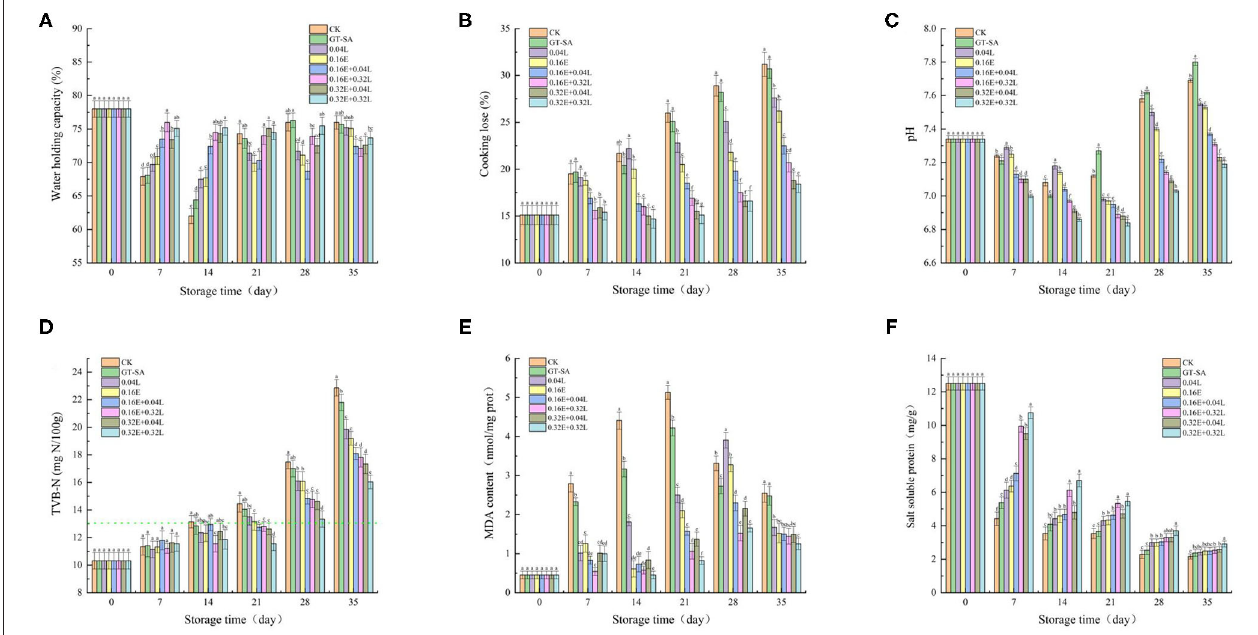
FIGURE 2 | Changes in water holding capacity [WHC, (A) ], cooking lose (B) , pH (C) , total volatile basic nitrogen values [TVB-N, (D) ], malondialdehyde content [MDA, (E) ], and salt soluble protein content (F) of large yellow croaker samples during superchilling storage (CK, uncoated; GT-SA, GT-SA coating without preservatives; 0.04L, GT-SA coating with 0.04 mg · ml − 1 LYS; 0.16E, GT-SA coating with 0.16 mg · ml − 1 EGCG; 0.16E + 0.04L, GT-SA coating with 0.16 mg · ml − 1 EGCG, and 0.04 mg · ml − 1 LYS; 0.16E + 0.32L, GT-SA coating with 0.16 mg · ml − 1 EGCG and 0.32 mg · ml − 1 LYS; 0.32E + 0.04L: GT-SA coating with 0.32 mg · ml − 1 EGCG and 0.04 mg · ml − 1 LYS; and 0.32E + 0.32L, GT-SA coating with 0.32 mg · ml − 1 EGCG and 0.32 mg · ml − 1